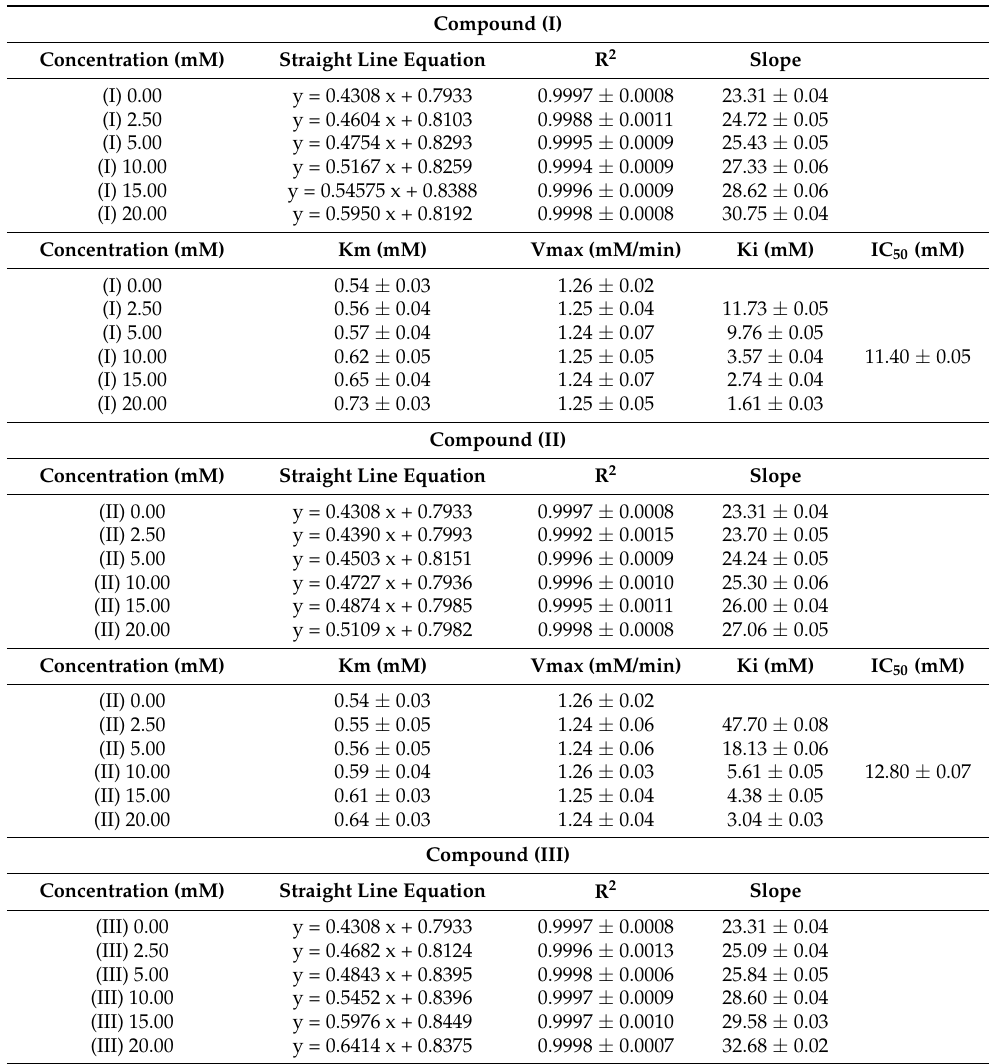
Table 4. The analytical data describing effects of catalase inhibition by aminoalkanol derivatives (I), (II), (III) and (IV) and regression equation for hydrogen peroxide for six replicates for each sample ( n = 6) at the concentration range 0.08–10.00 mM, in the presence of inhibitors (I), (II), (III) and (IV), at a concentration of 2.50, 5.00, 10.00, 15.00 and 20.00